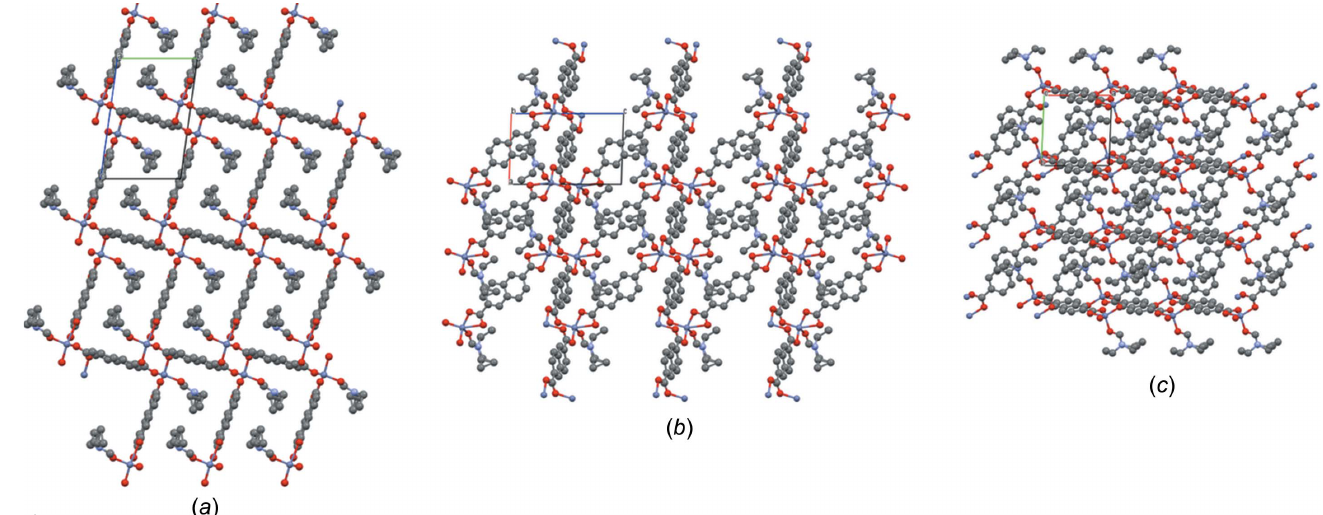
Figure 5 View of the two-dimensional stacked layers in MOF 1 along the crystallographic ( a ) a , ( b ) b and ( c ) c